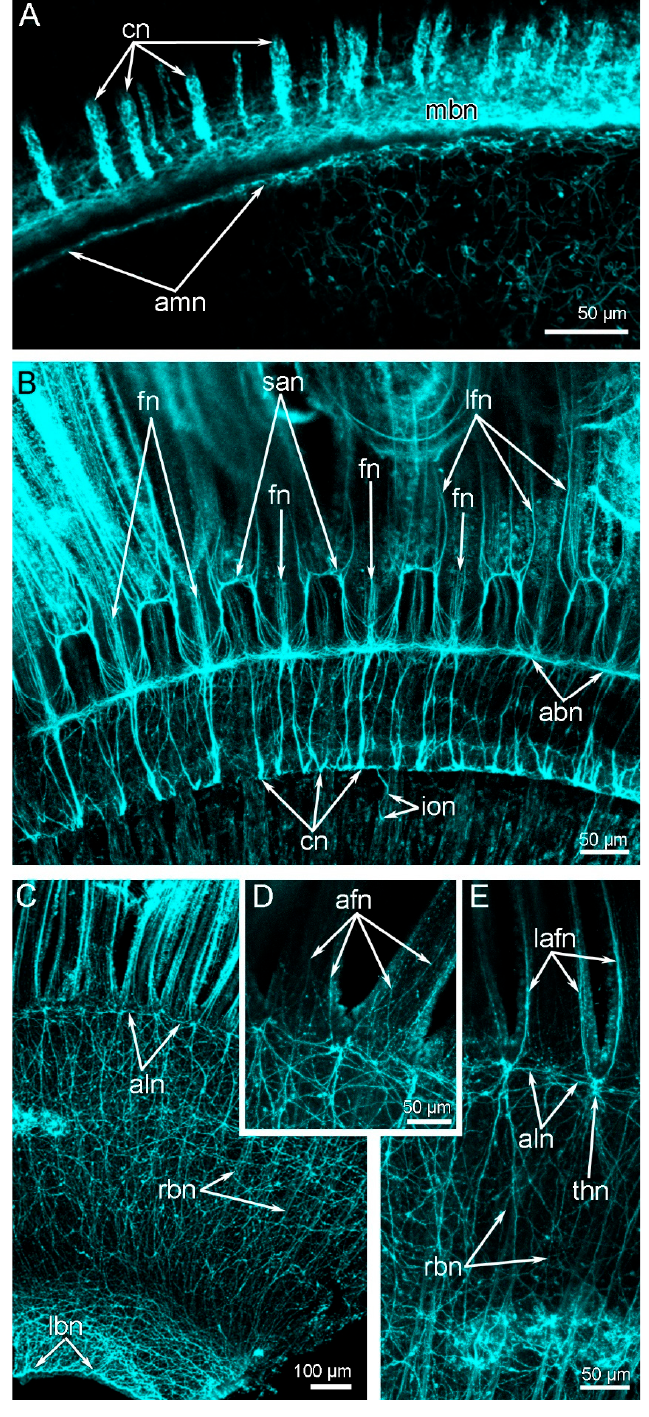
Figure 7. Brachial nerves and the innervation of tentacles in Novocrania anomala adults. Z-projections after immunostaining against acetylated alpha-tubulin (cyan). ( A ) The main brachial nerve and its additional part—the additional main brachial nerve. ( B ) The accessory and second accessory brachial nerves; frontal and latero-frontal tentacle nerves of both inner and outer tentacles originate from the second accessory nerve. ( C ) Outer side of the lophophore arm: the lower and additional lower nerve are visible. ( D ) The base of two outer tentacles. ( E) The base of the outer tentacles: lateroabfrontal tentacle nerves originate from the thick nodules of the additional lower brachial nerve. Abbreviations: afn—abfrontal tentacle nerve; abn—accessory brachial nerve; aln—additional lower brachial